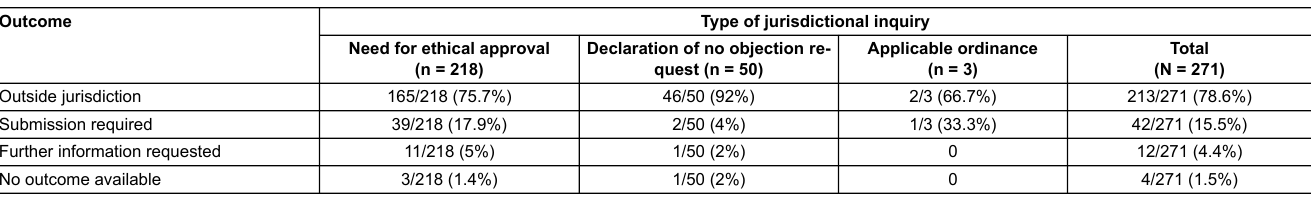
Table 3: Outcome of the jurisdictional